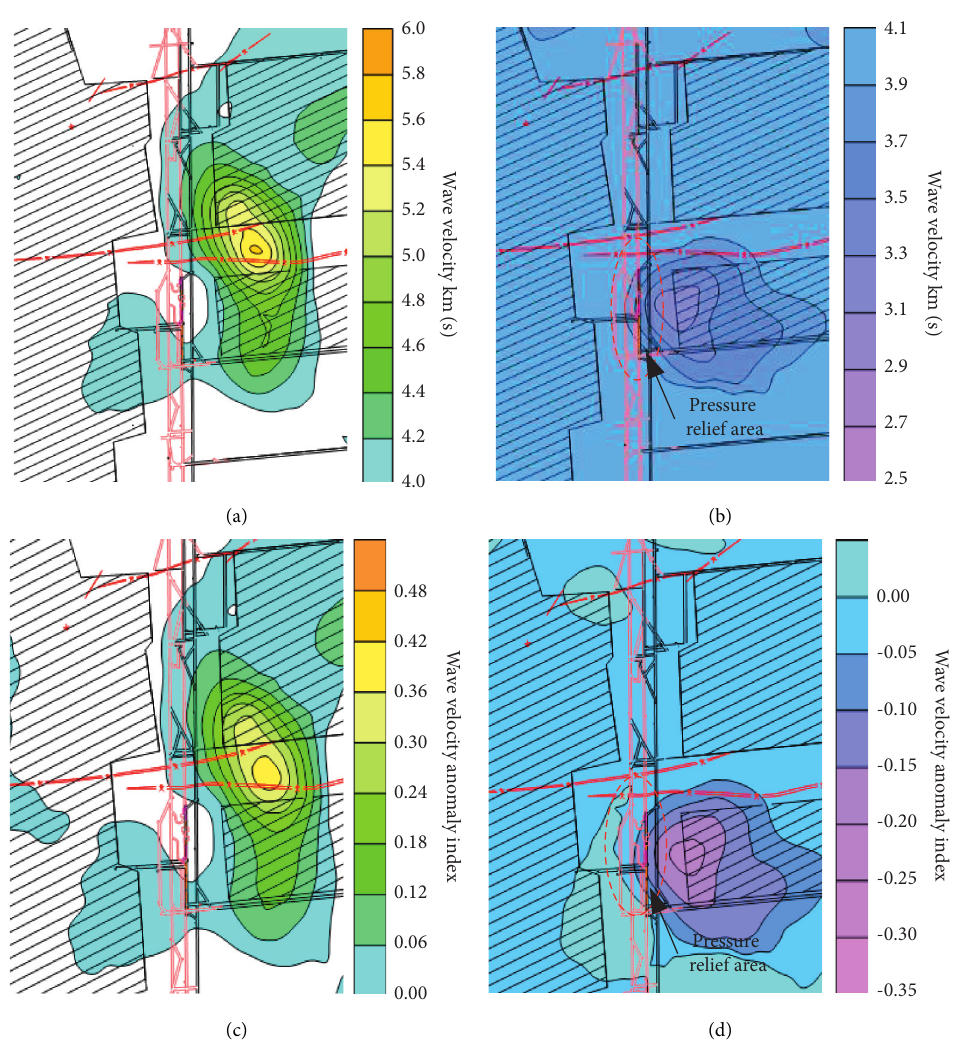
Figure 20: Seismic CTdetection results before and after decompression in the III-III section area of the isolated coal pillar. (a) Characteristics of wave velocity distribution before decompression (2018.07.10–2018.07.29). (b)Characteristics of wave velocity distribution after deconfliction (2018.08.01–2018.08.20). (c) Distribution characteristics of wave speed anomaly index ( A n ) before decompression. (d) Distribution char- acteristics of wave speed anomaly index ( A n ) after